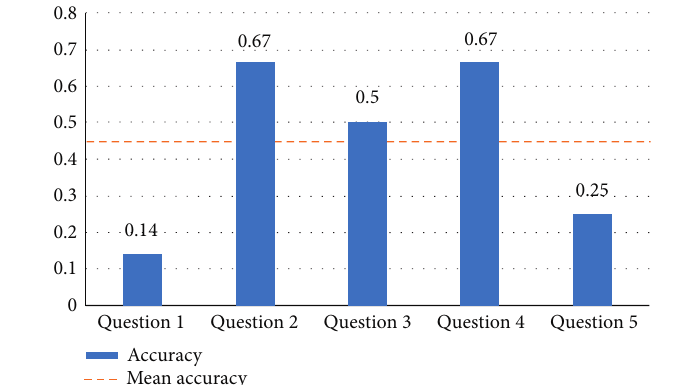
Figure 5: Accuracy score of recommended experts.